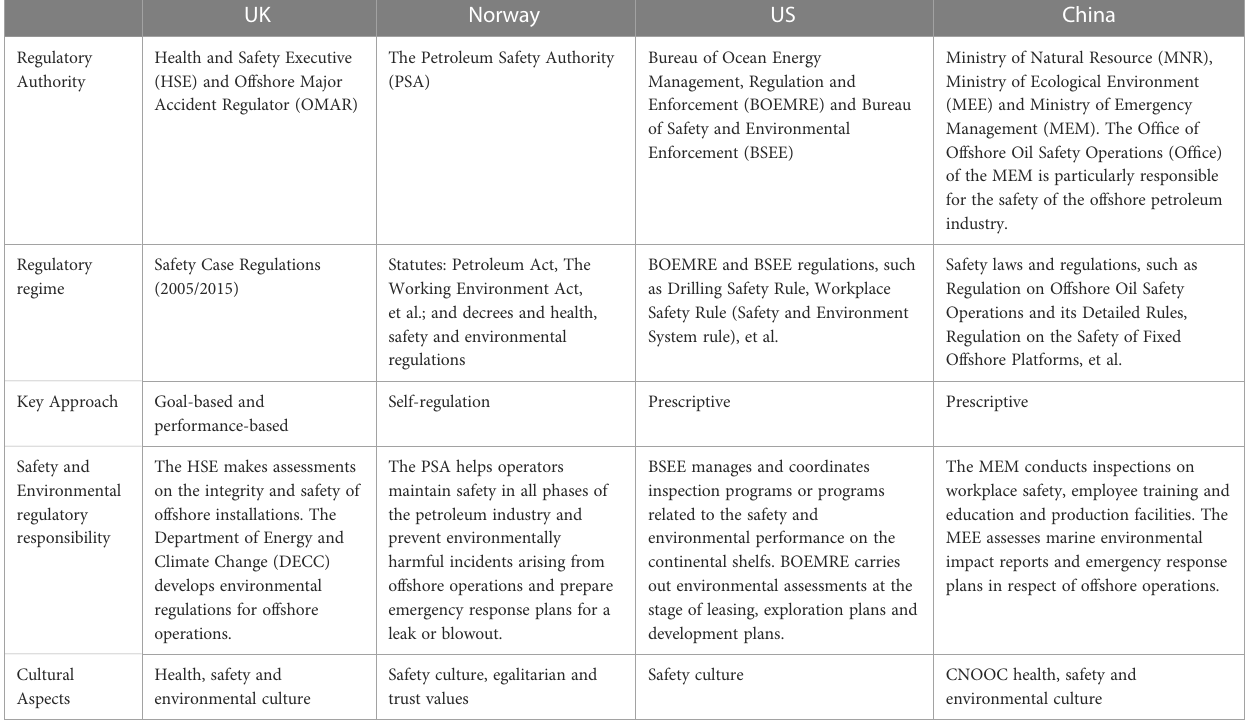
TABLE 1 Key aspects of offshore risk regulation in the UK, Norway, the US and China.